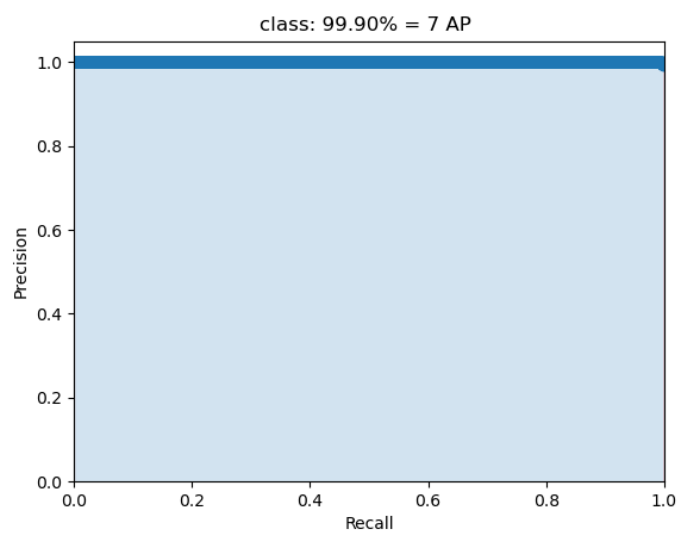
Figure 11. Precison-Recall curve of “7”.